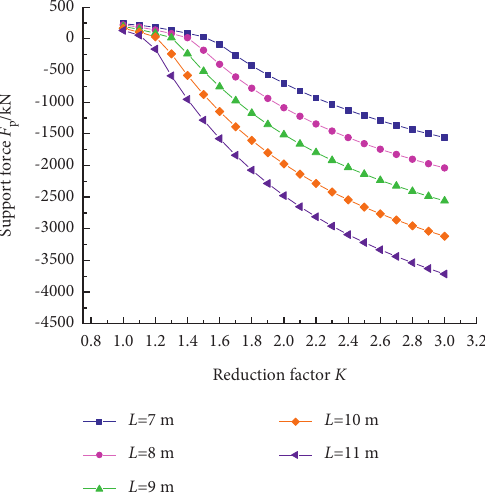
Figure 5: Retaining force versus dip angle of structural plane. Figure 6: Retaining force versus strength reduction